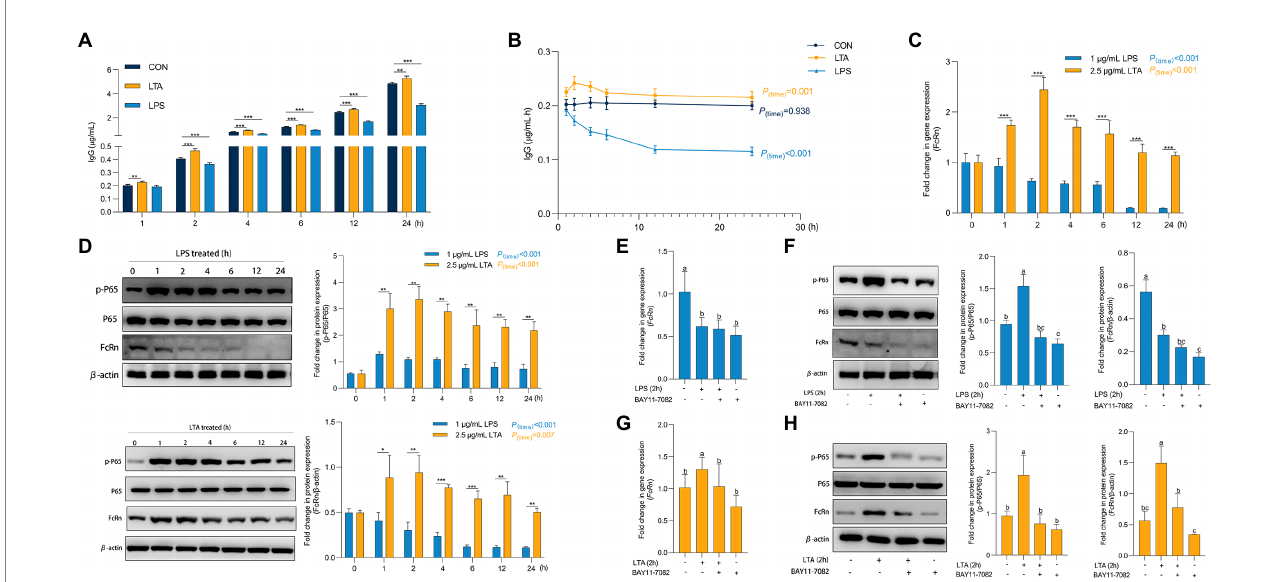
FIGURE 4 Role of P65 phosphorylation in transmembrane transport of IgG. (A,B) Transmembrane transport of IgG after LPS and LTA stimulation. (C) The mRNA expression of FcRn after LPS and LTA stimulation. (D) The protein expression of FcRn, P65, and P65 phosphorylation after LPS and LTA stimulation. (E–H) The mRNA expression of FcRn and the protein expression of FcRn, P65 and P65a phosphorylation after blocking NF- κ B signaling pathway and then stimulated by LPS and LTA. Data were shown as means ± standard deviations. * p < 0.05, ** p < 0.01, *** p < 0.001. Mean value without the common letter on data bar in each figure indicated that the difference was significant ( p <